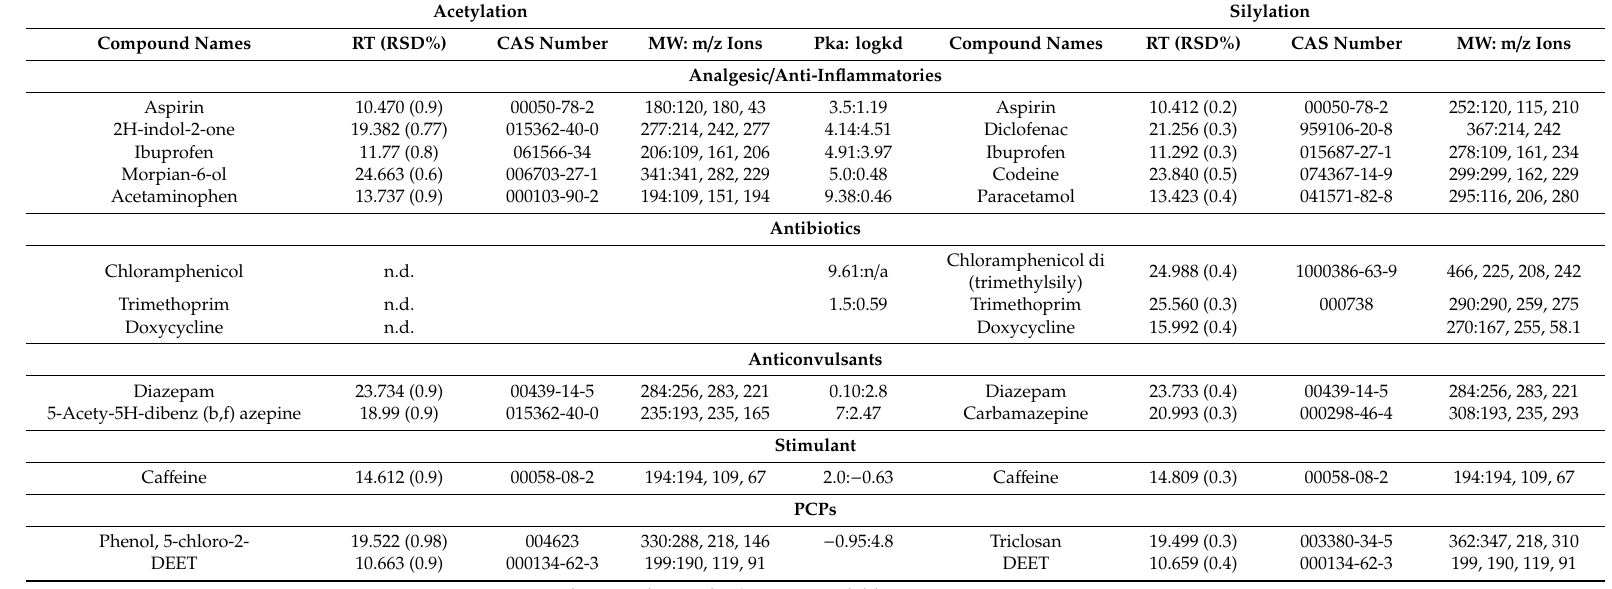
Table 5. Results and properties of acetylation and silylation derivatization of the 13 analytes; retention time (RSD%, n = 6), CAS numbers, ions, and pka, log